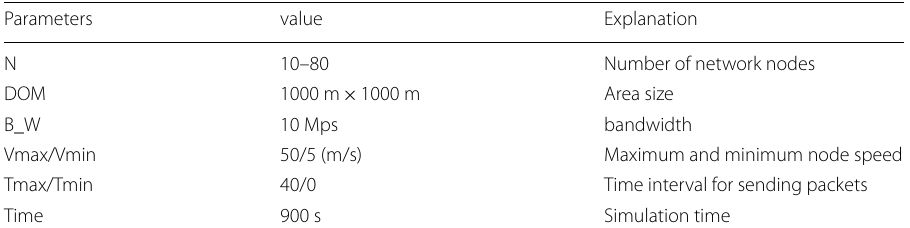
Table 3 Experimental parameters and their configuration Parameters